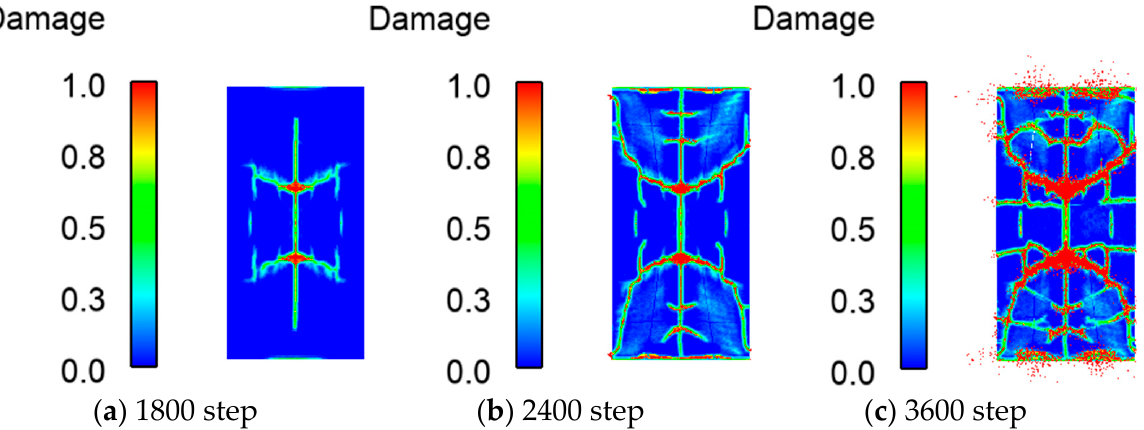
Figure 11. Crack development process at the back of the RC shear wall after falling hammer contact with the RC shear wall.